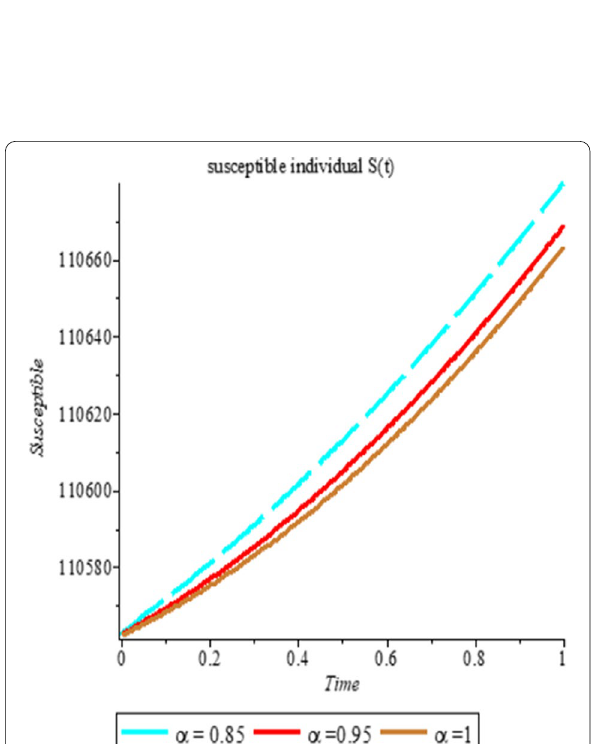
Fig. 3 Plot shows the behavior of E ( t ) at different values of fractional order